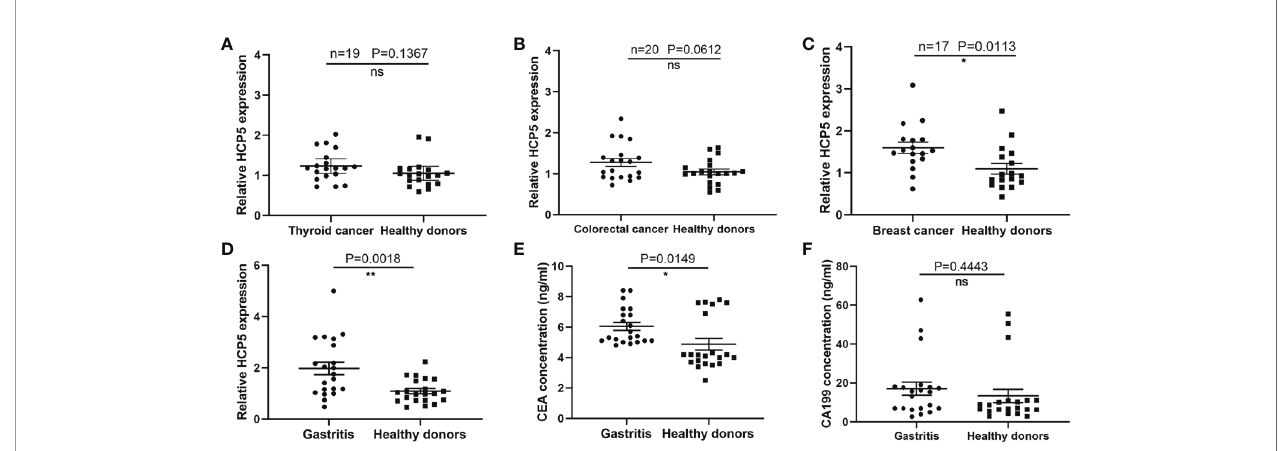
FIGURE 4 | The speci fi city of serum HCP5 in GC and differentiating from gastritis and healthy donors. (A) Detection of serum HCP5 in 19 thyroid cancer patients. (B) Detection of serum HCP5 in 20 colorectal cancer patients. (C) Detection of serum HCP5 in 17 breast cancer patients. (D) The expression levels of HCP5 in gastritis patients (n=21) and healthy donors (n=21). (E) The concentrations of CEA in gastritis patients (n=21) and healthy donors (n=21). (F) The concentrations of CA199 in gastritis patients (n=21) and healthy donors (n=21). *P < 0.05, **P < 0.01, NS means no statistically